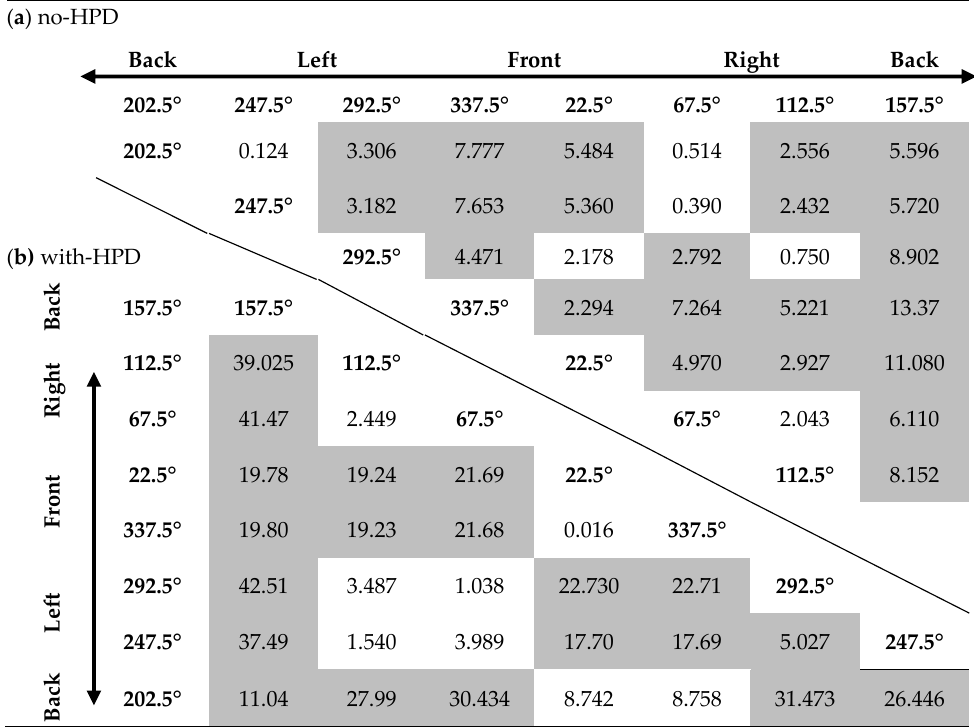
Significant comparisons are marked with shaded cells.